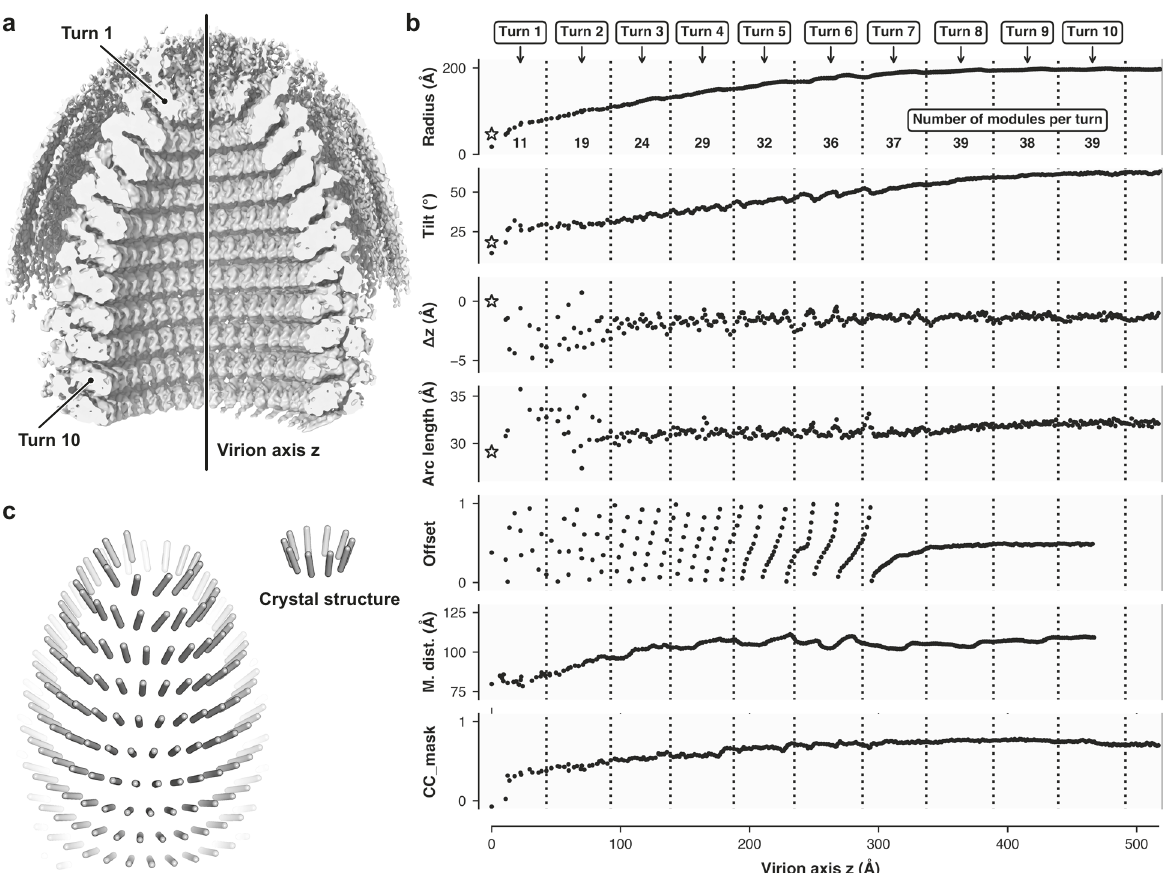
Fig. 5 | Structure ofthe VSV tip. a Asymmetric reconstruction of the VSV tip. The density was low pass fi ltered at 8.8Å resolution and sharpened by applying a B factor of − 100 Å 2 . To allow inside view, the density is partially cut. b Analysis of individual modules after rigid body fi tting into the map of the VSV tip recon- struction.The horizonalaxisisthe distancefrom the top of the tip along thevirion axis.Eachdot correspondstoone module.Turns are delineated ontopof the plot. Asterisks in the plots are values calculated from the crystal structure of the deca- meric N-RNA complex 3 . Radius: distance between the virion axis and the center of gravityofthenineRNAbases.Tilt:tiltoftheNproteinrelativetothehelicalaxis. Δ z: